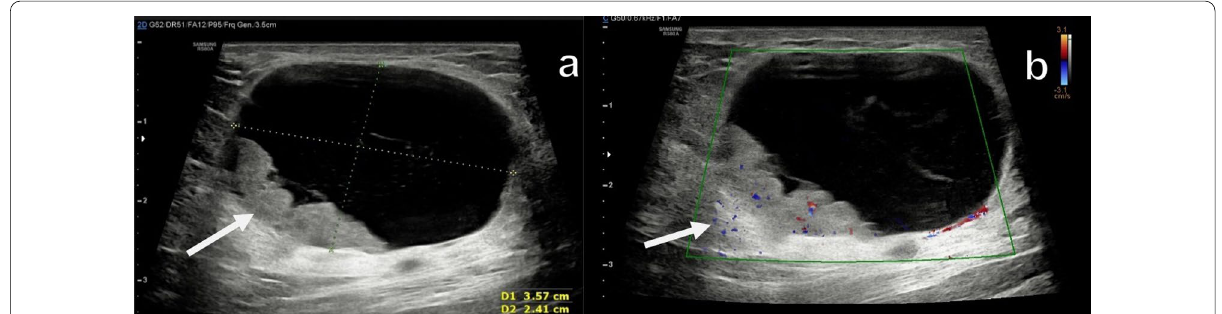
Fig. 2 Ultrasonography demonstrates an oval, circumscribed cystic lesion with an echogenic solid mural component within it ( a ) and color doppler showing vascularity in solid component ( b